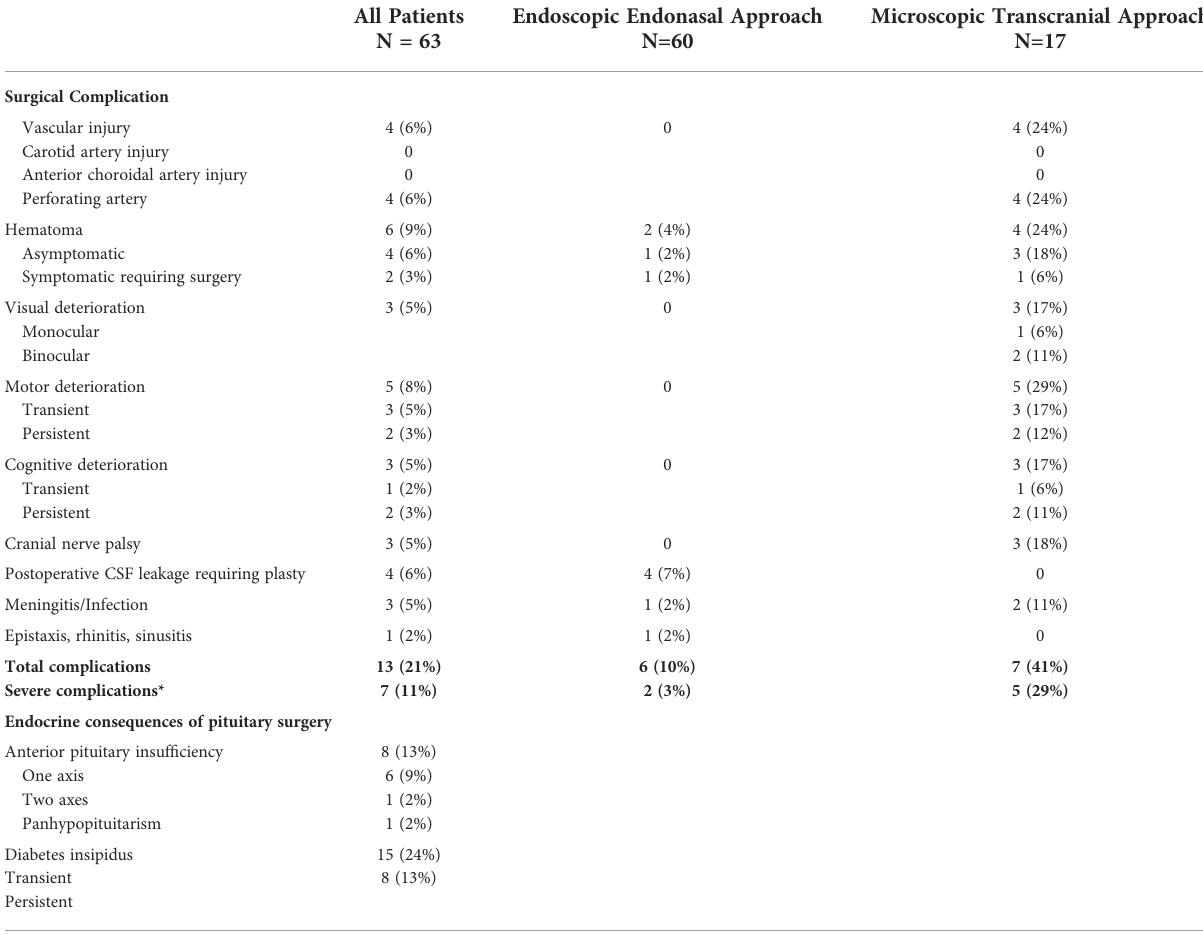
TABLE 3 Complications and endocrine consequences of pituitary surgery Data are expressed as N